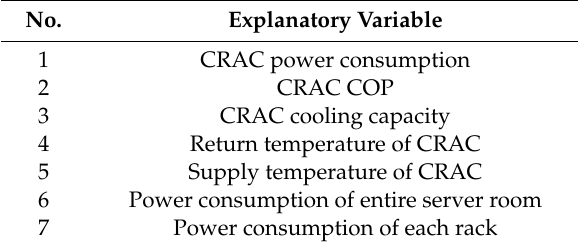
Table 3. Explanatory variables used in the model for predicting rack intake temperature.